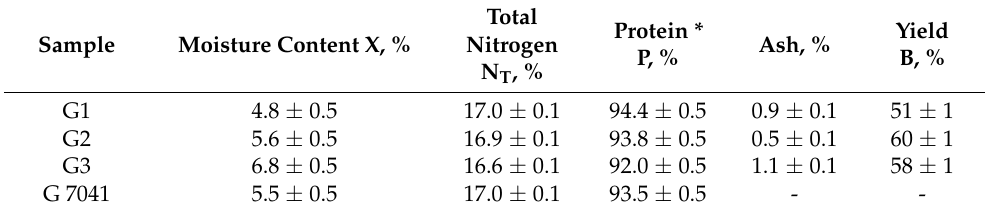
Table 2. Chemical composition of gelatin